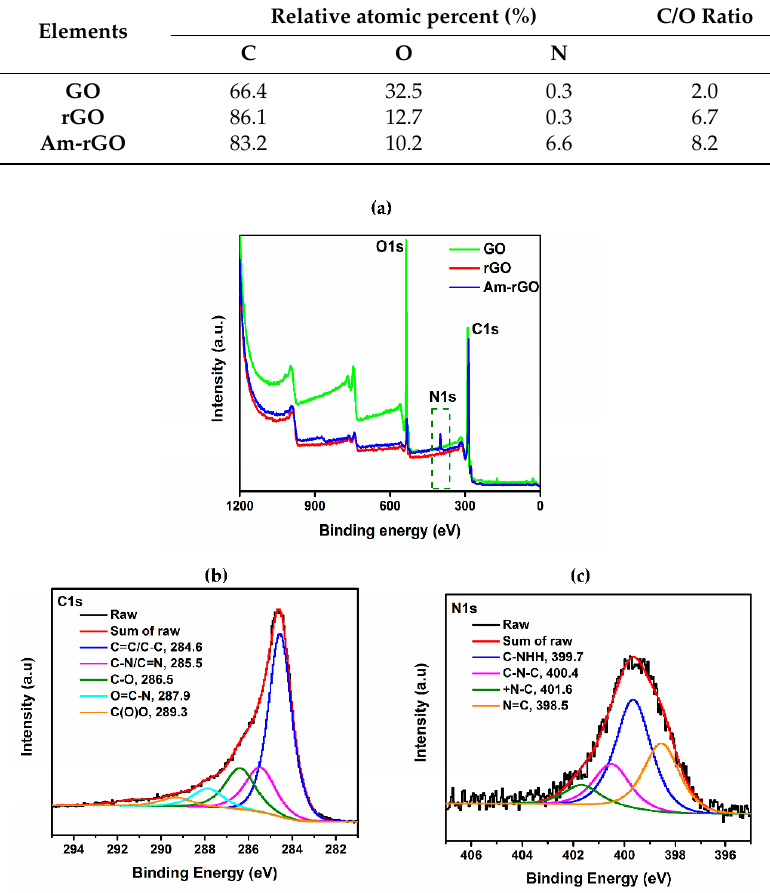
Figure 4. ( a ) XPS survey of GO, rGO and Am-rGO. High resolution XPS spectra of ( b ) C1s and ( c ) N1s of Am-rGO.